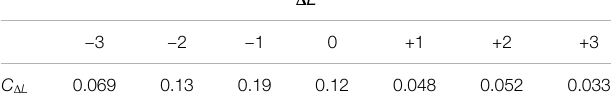
TABLE 3 | Coef fi cients of spiral spectrum modes for an astigmatism phase. Δ L − 3 − 2 − 1 0 + 1 + 2 +